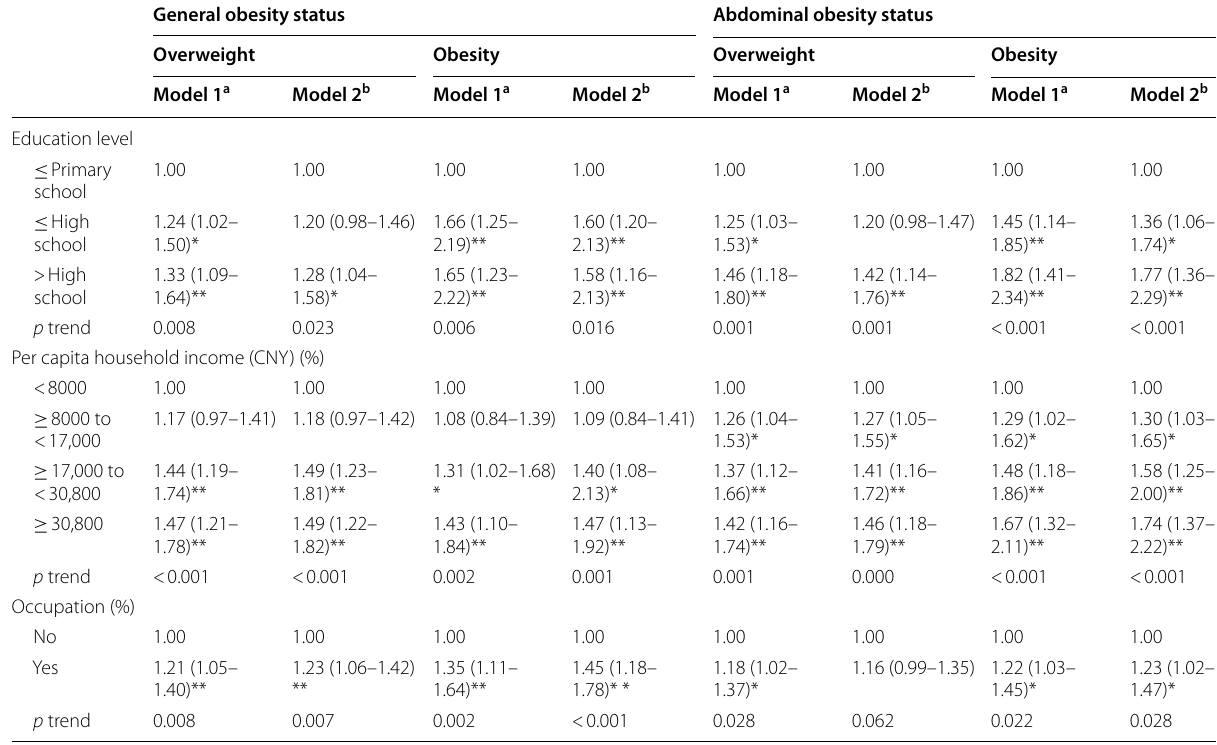
Table 2 Odds ratios (ORs) with 95% confidence intervals (CIs) of socio-economic factors related to overweight and obesity in